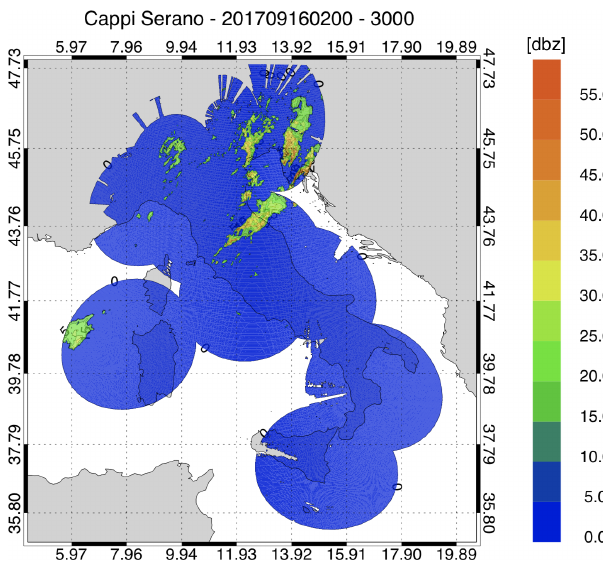
Figure 4. National radar mosaic at 3km above the sea level ob- served at 02:00UTC on 16 September 2017.